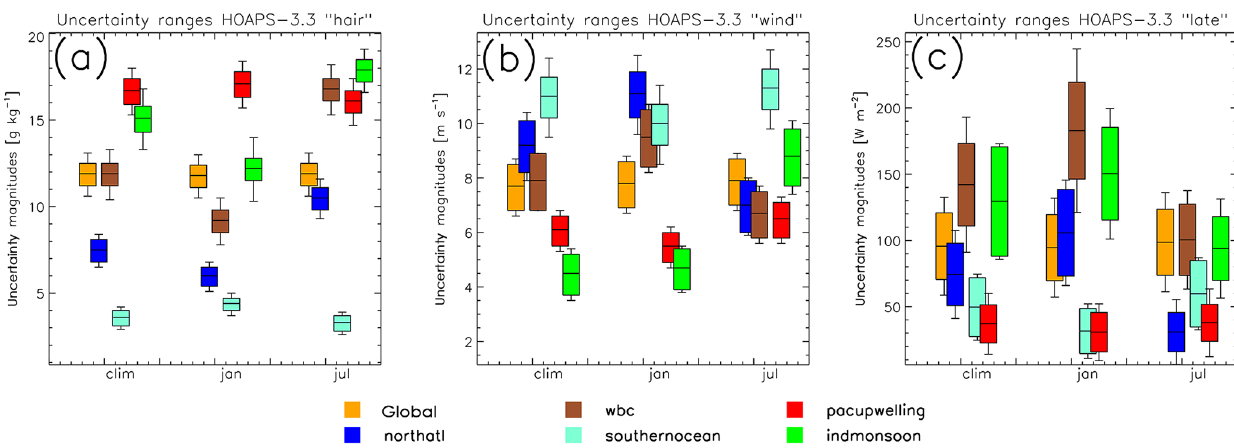
Figure 5. (a) Expected ranges of q a (“hair”) as a function of different regions and seasons. The colour-coded boxes show E clim (1988–2012), whereas the bars indicate the average instantaneous random uncertainty component E ran retr (1988–2012). The following regions are presented: global (orange), North Atlantic (60 ◦ W–5 ◦ E, 35–65 ◦ N; dark blue), North Atlantic western boundary current (WBC, 60–80 ◦ W, 30–40 ◦ N; brown), Southern Ocean (50–60 ◦ S; cyan), Pacific upwelling regime (80–100 ◦ W, 5 ◦ N–5 ◦ S; red), and Indian monsoon region (50–75 ◦ E, 15–30 ◦ N; green). (b) As for panel (a) , but for U (“wind”). (c) As for panel (a) , but for LHF (“late”). Table 2. Average of monthly mean HOAPS 3.3 LHF-related sampling uncertainties ( E smp ) as a function of simultaneously operating SSM/I instruments (1995–2008). q a is “hair”, U is “wind”, q s is “hsea”, LHF is “late”, SST is “asst”, E is “evap”, and air temperature is “tair”. All magnitudes are negligible compared to the instantaneous random ( E ran retr ) and climatological uncertainties ( E clim ) presented in Sects. 4.2 and 4.3. No. of satellites/ “hair” “wind” “hsea” “late” “asst” “evap” “tair” parameters (gkg − 1 ) (ms − 1